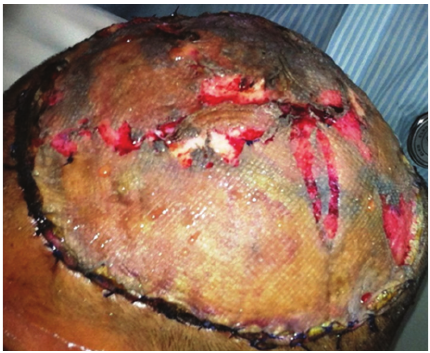
Figure 4: Two-week follow-up revealed healthy graft with granula- tion tissue and > 90%